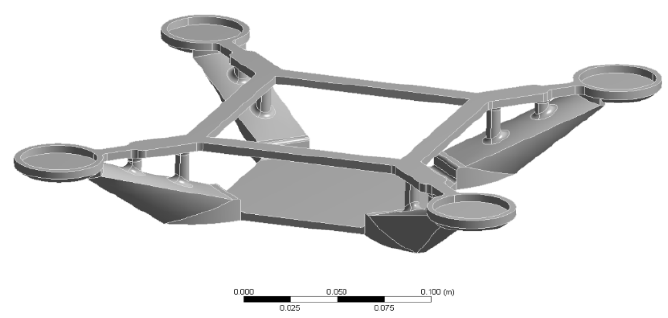
Figure 9. Optimized geometry.